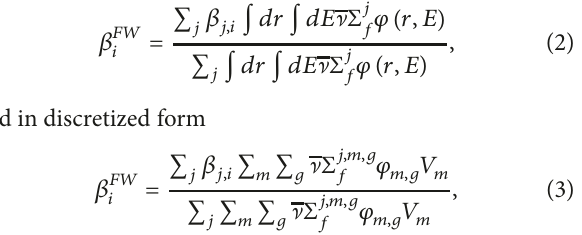
𝑎 In this table: F refers to fast fission and T refers to thermal fission. 𝑏 Due to lack of data for group 6, the measured data of the fast group is used in the thermal